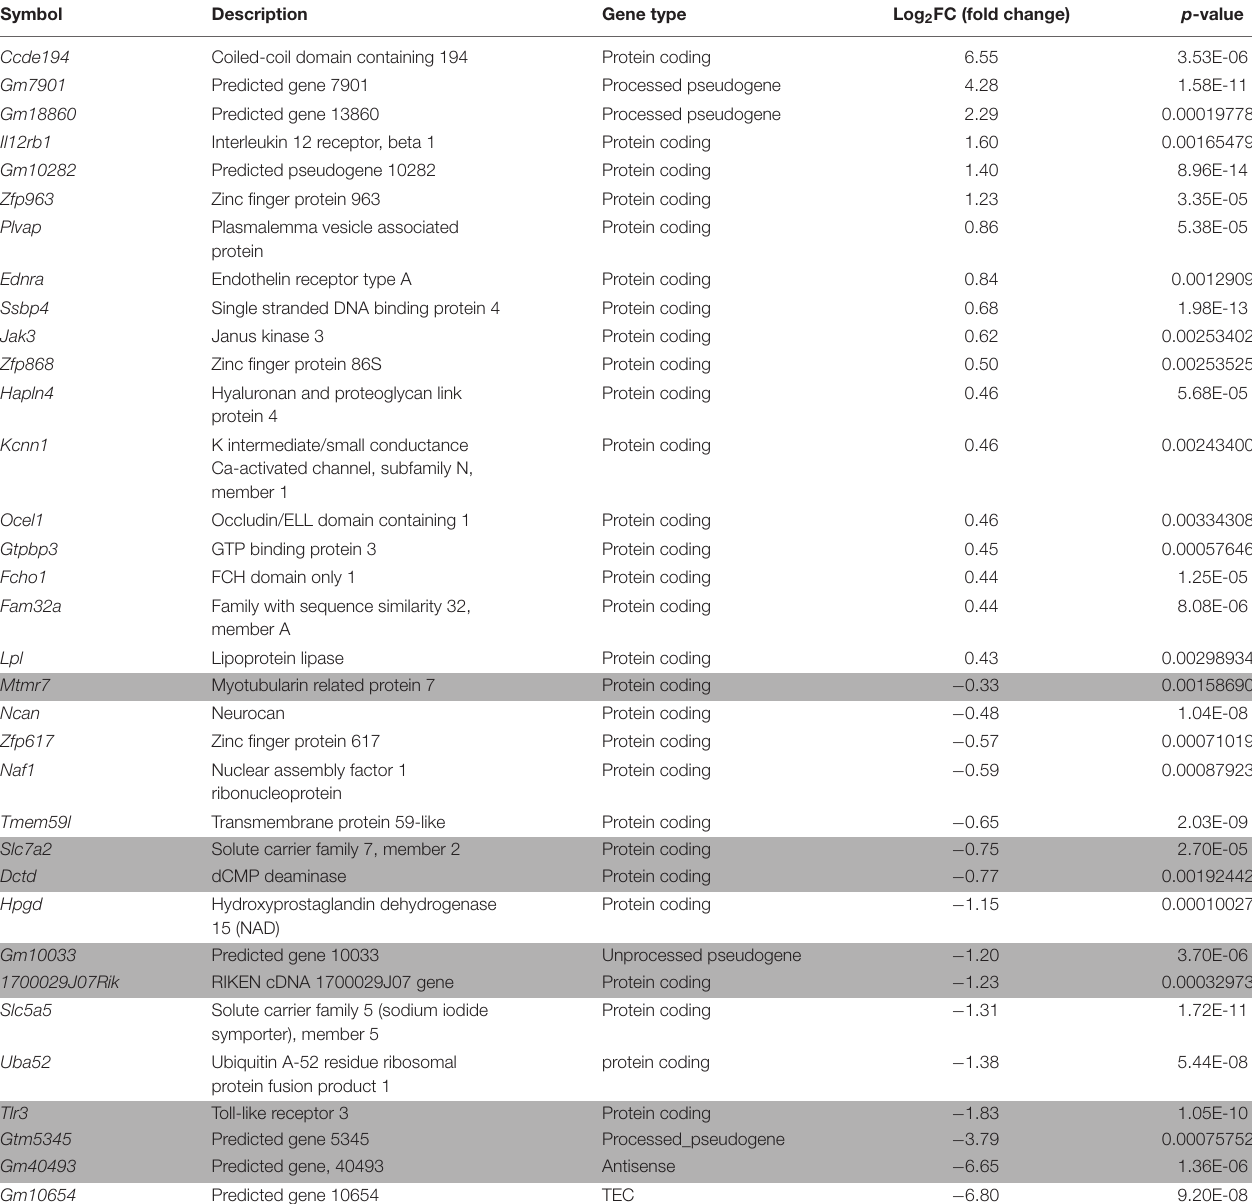
TABLE 4 | Differential gene expression between WSB and B6 determined by RNA sequencing analysis.